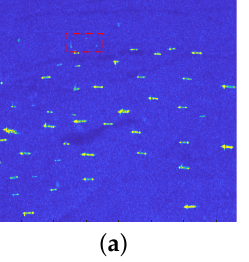
Figure 5. Scene 4 with small ship targets and small target slice. ( a ) scene 4; ( b ) small target slice marked by the red dotted rectangle in ( a ).